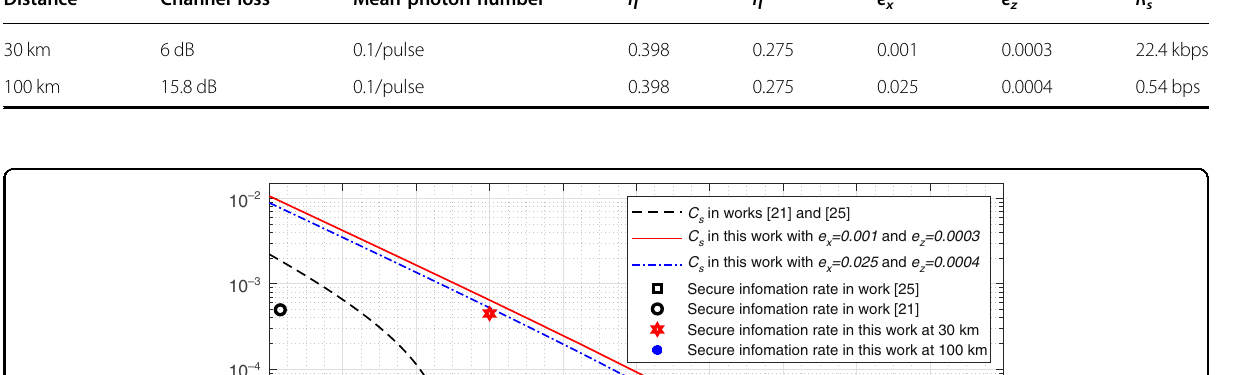
Table 1 Experimental parameters and performance Distance